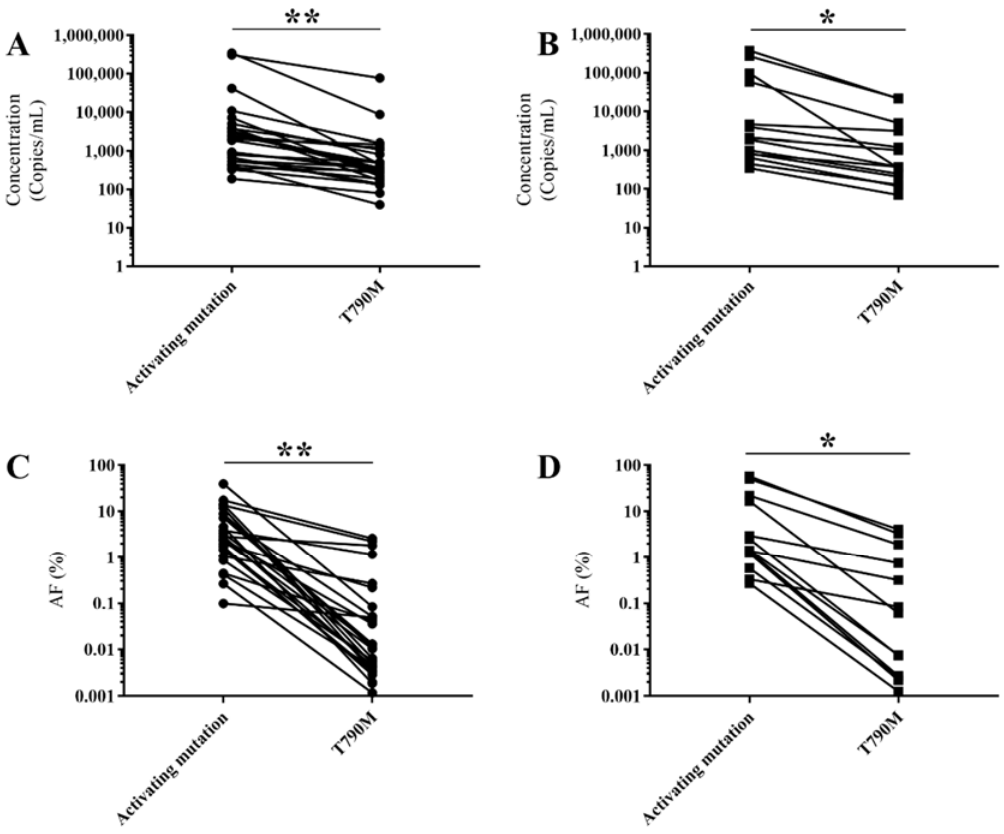
Figure 2. Comparison of ctDNA (activating mutations vs. T790M mutation) ( n = 43). ( A , B ) concentration (copies/mL) of EGFR activating mutations (ex19del, L858R, L861Q, and G719X) versus T790M mutation detected in samples taken at radiological progression ( n = 29) ( A ) and during follow up ( n = 14) ( B ), respectively. The lowest detectable concentration was 190 and 40 copies/mL, with a median of 1950 and 360 copies/mL, respectively; ( C , D ) distribution of the allele frequencies detected in samples taken at radiological progression ( n = 29) ( C ) and during follow up ( n = 14), respectively. The lowest allele frequency detected was 0.0985 and 0.0012%, with a median of 2.530 and 0.0107%, respectively; * p < 0.05; ** p < 0.001.